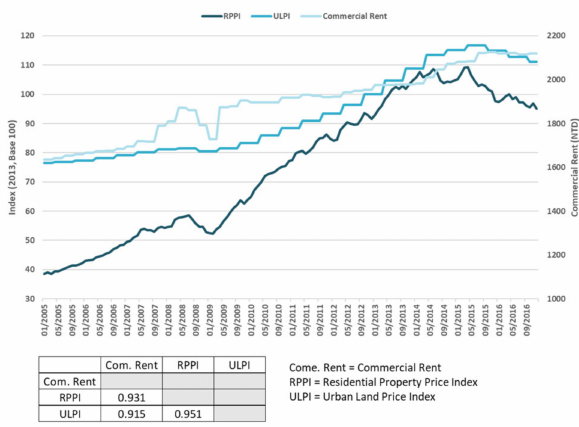
Figure 4. Correlations between land prices and property prices.